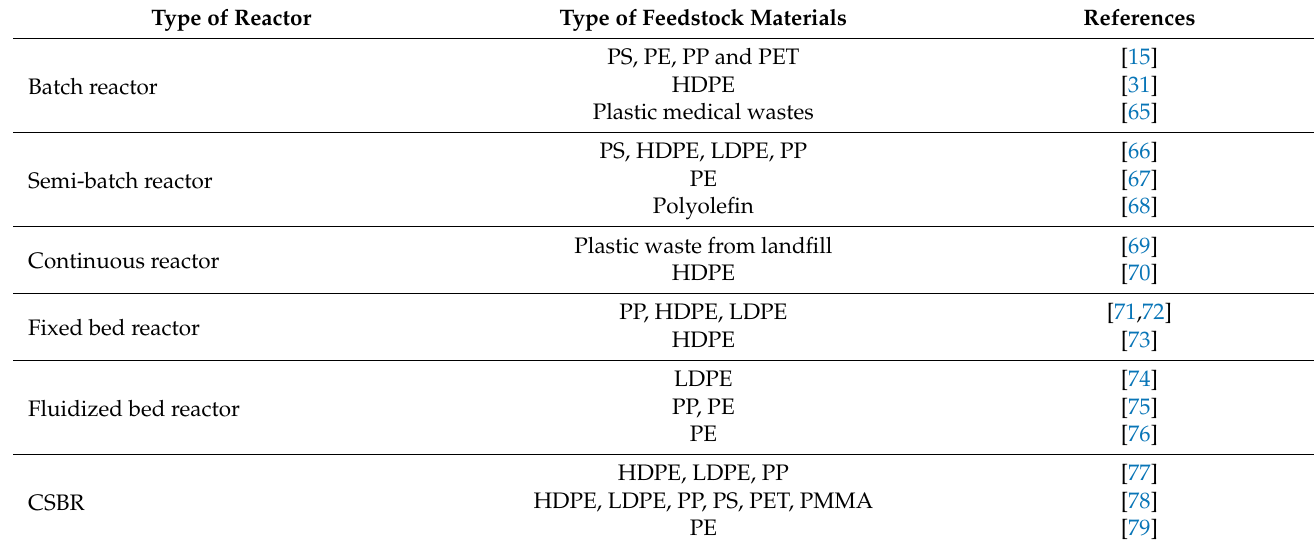
Table 1. Examples of reactors for polymer pyrolysis.